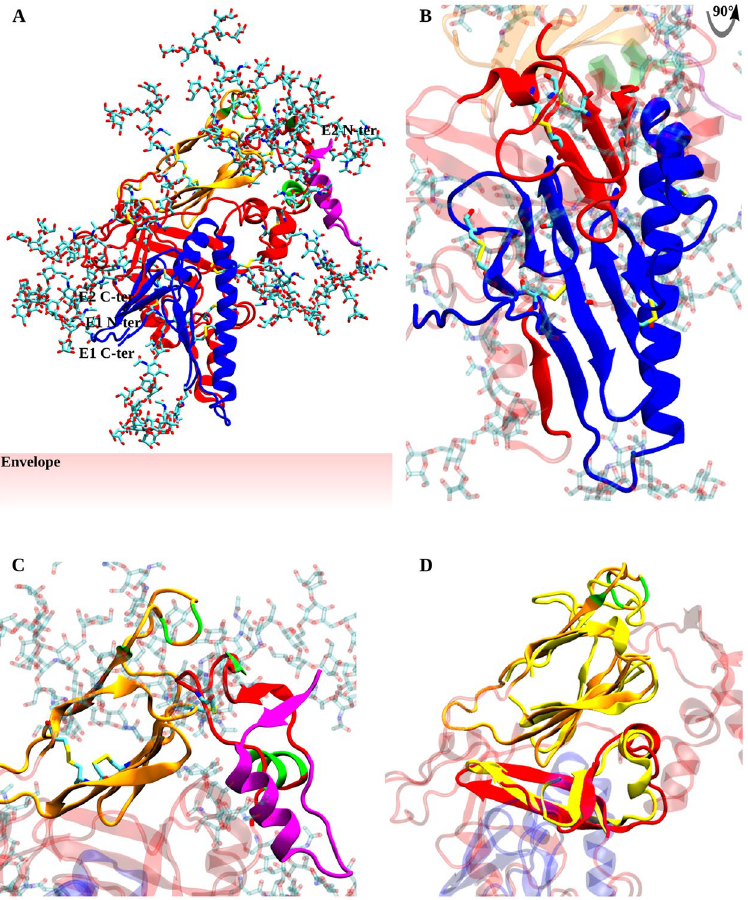
Figure 4. E1E2 heterodimer model. E1 and E2 structures are represented in cartoon and colored in blue and red, respectively. E2 HVR1, Ig-like domain and CD81bs are colored in purple, orange and green, respectively. Glycosylations are in licorice representation. ( A ) Overview of the entire, fully-glycosylated structure. ( B ) Details of E1, E1-E2 interfaces and the protective role of the variable regions HVR2 and IgVR on E1. These domains are depicted in solid colors, while the remaining E2 segments are transparent. ( C ) Protective role of HVR1 on CD81bs. Residues included in the CD81bs, Ig-like domain and HVR1 are in solid colors, all other regions are transparent. ( D ) Structural alignment of the E2c structured portions and the E1E2 model. 4MWF structure is aligned to the same regions of the model and colored in solid yellow. Model domains not superimposed to 4MWF are transparent. Glycosylations were removed for